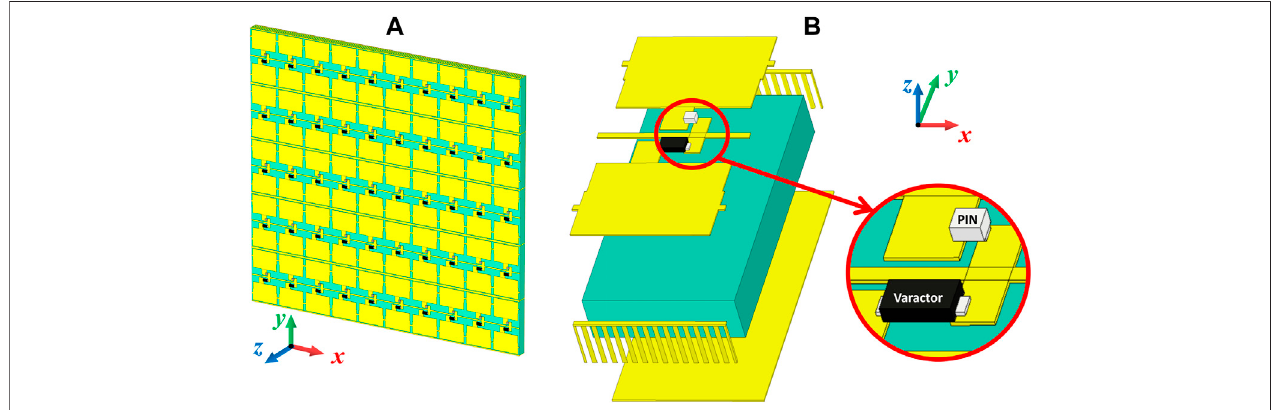
FIGURE 1 | (A) Schematic diagram of the RIS array and (B) its close-up view of programmable elements integrated with a PIN-diode and a varactor.